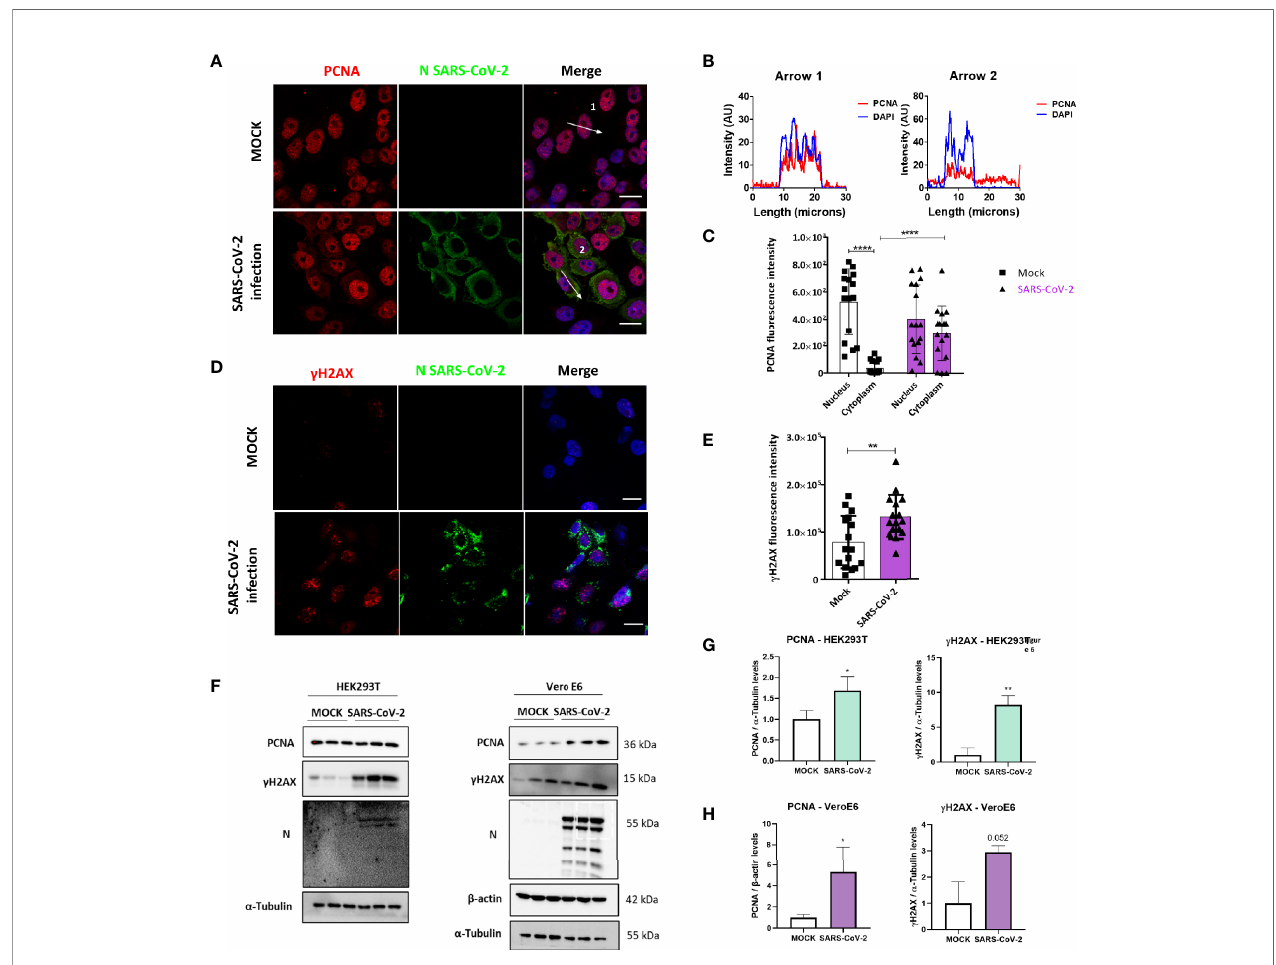
FIGURE 5 | SARS-CoV-2 infection promotes PCNA translocation to the cytoplasm and enhances PCNA and g H2AX expression. (A) Vero E6 cells were infected with SARS-CoV2 (MOI 0.3), and 24 hours post-infection immuno fl uorescence was performed for N (green) and PCNA (red). Scale bars 20 m m. (B) Plot pro fi le intensities for PCNA and DAPI channels in the cross-sections, indicated by arrows 1 and 2. Images are representative of two independent experiments. Scale bar 20 m m. (C) PCNA localization was analyzed through fl uorescence intensity mock versus infected cells, as described in Figure 2B . White bars = mock, purple bars = SARS-CoV-2 infection. (D) Vero E6 cells were infected with SARS-CoV2 (MOI 0.3), and 24 hours post-infection immuno fl uorescence was performed for N (green) and g H2AX (red). Scale bars 20 m m. (E) Fluorescence intensity of g H2AX in the nucleus was analyzed in mock and infected cells, as described in Figure 2B . White bars = mock, purple bars = SARS-CoV-2 infection. (F) Western blotting analysis of PCNA and g H2AX levels in HEK293T and Vero E6 cells infected with SARS-CoV- 2 compared to mock. Statistical analysis for normalized expression levels of PCNA and g H2AX are shown for HEK293T (G) and Vero E6 cells (H) . Data represent means ± SD from 1 independent experiment. For fl uorescence intensity (n = 20), data were analyzed by Two-way ANOVA and multiple comparisons Bonferroni ’ s test. *p < 0.05 and ****p < 0.0001 were considered statistically signi fi cant **p <